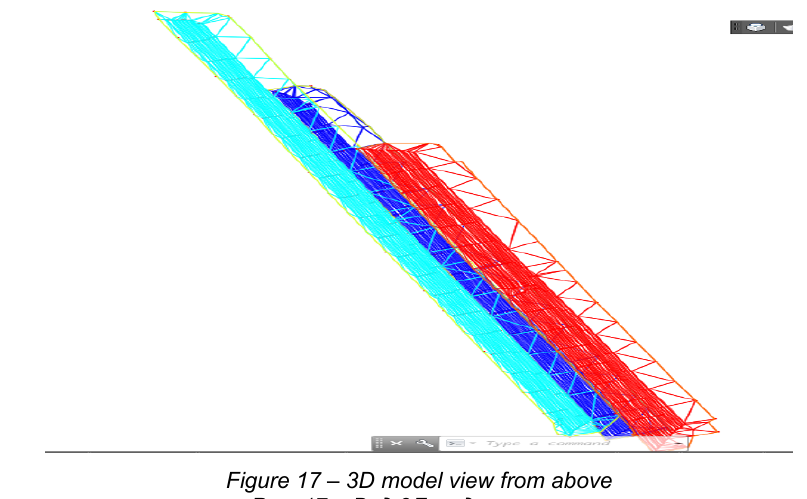
Figure 17 – 3D model view from above Рис . 17 – Вид 3 Д модели